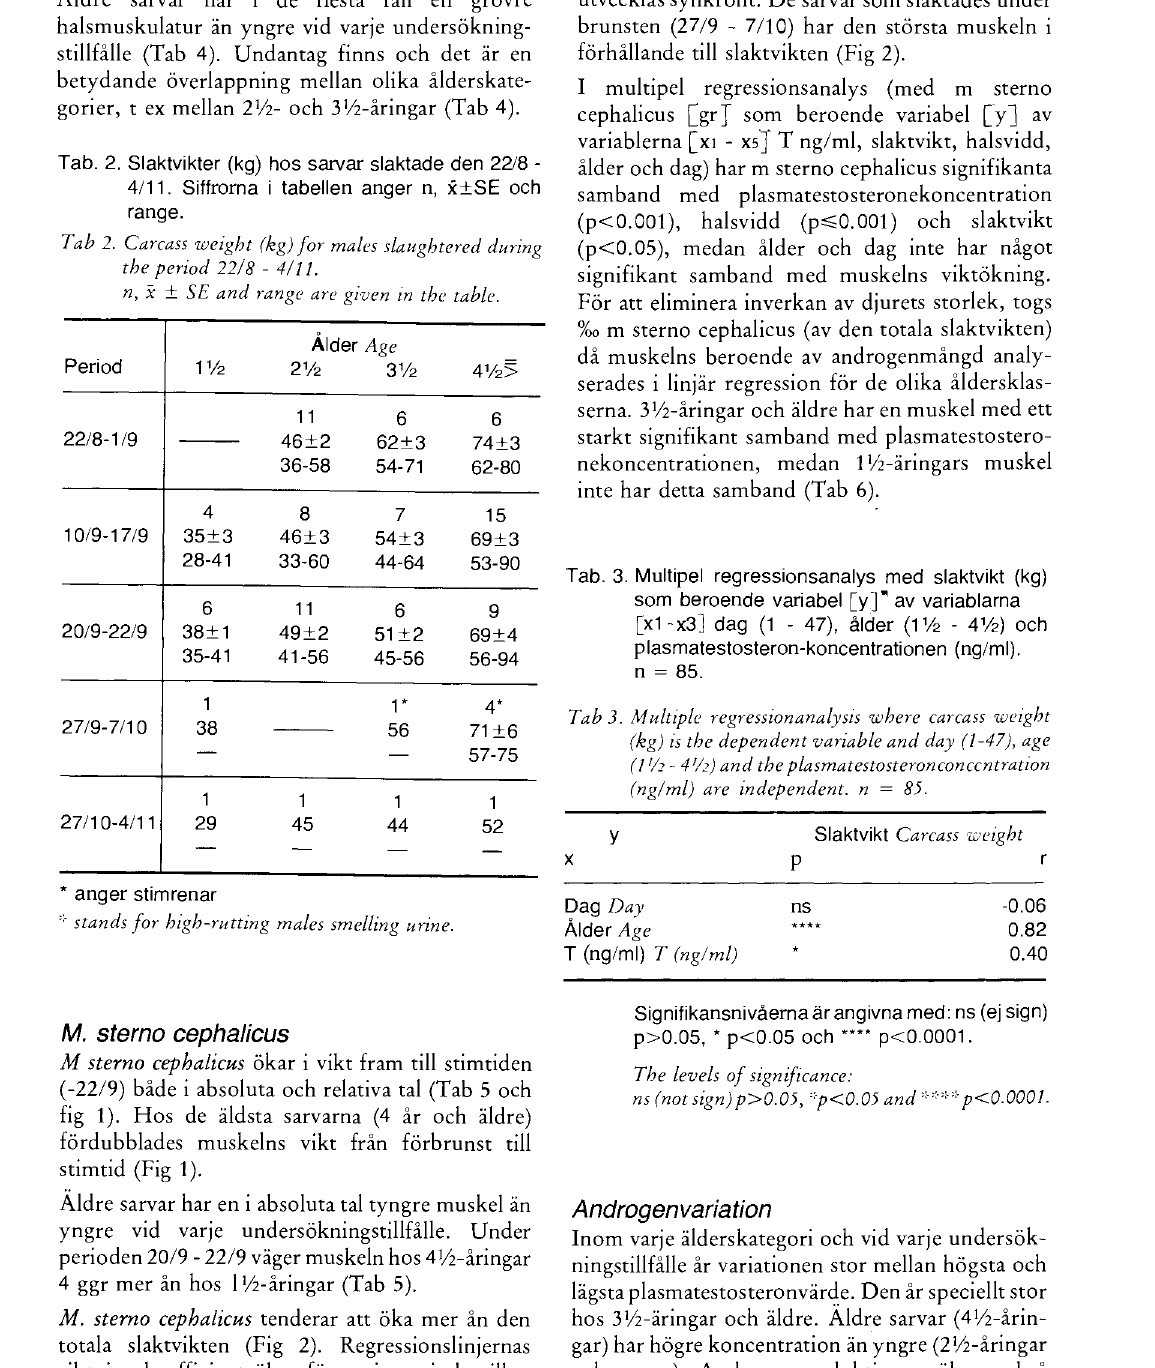
Tab 2. Carcass weight (kg) for males slaughtered during the period 22/8 - 4/11.